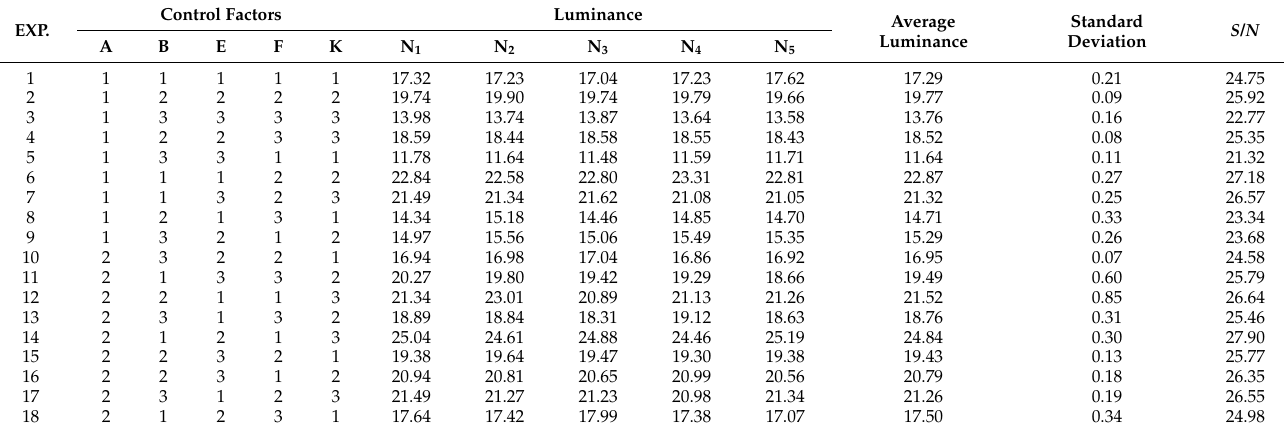
Table 9. L 18 (2 1 × 3 7 ) orthogonal array and data for the Taguchi method experiment. EXP.